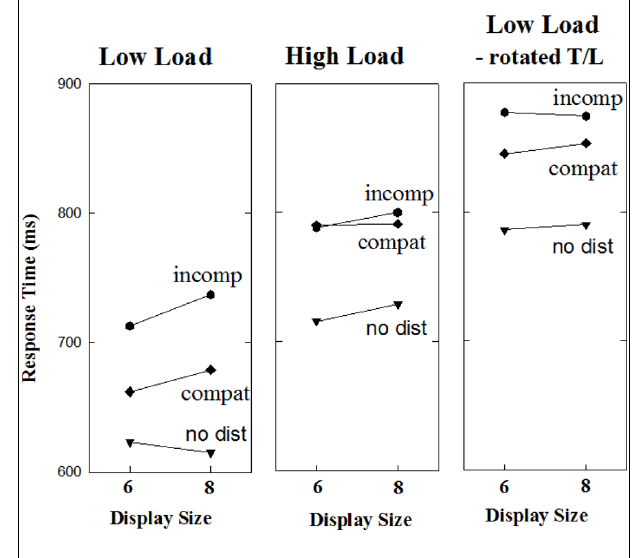
FIGURE 3 | Mean response time as a function of display size and distractor type in Experiments 2a (right panel), 2b (middle panel), and 3 (right